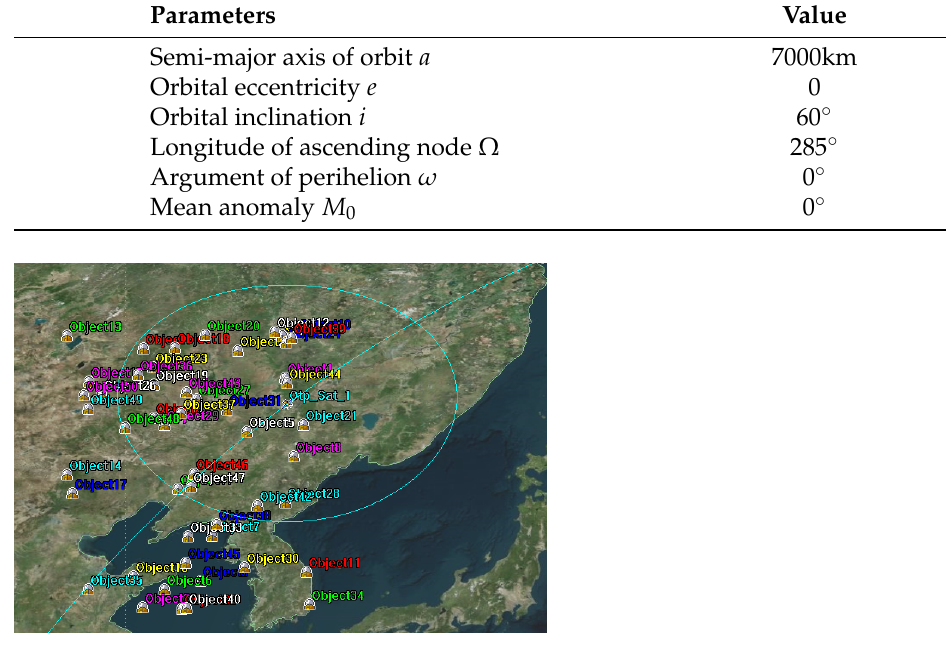
Figure 7. Observation target point map.